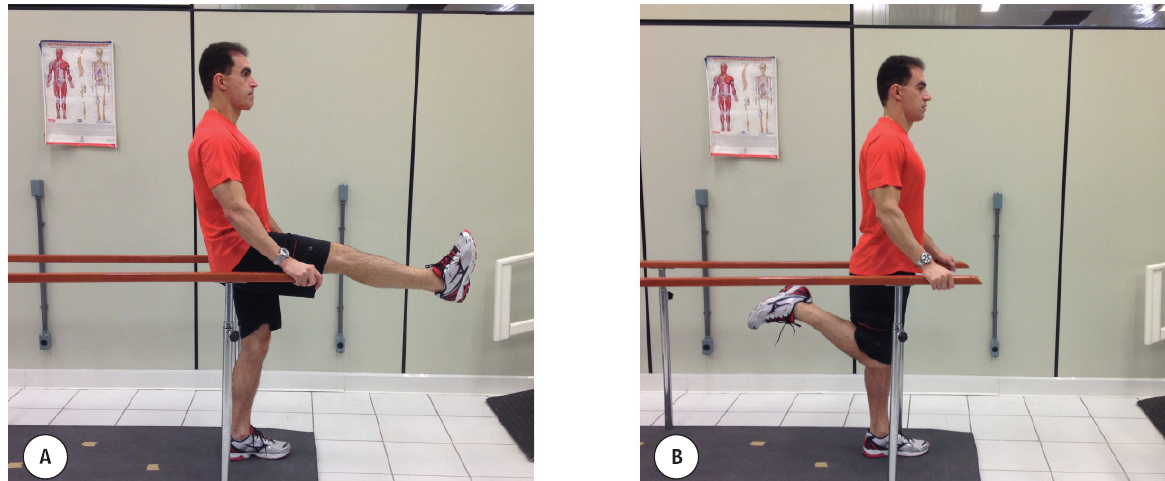
Figure 2 - Posture adopted by subjects during the stretching exercises targeting the hamstrings (A) and quadriceps (B) muscle groups Source: Research data.